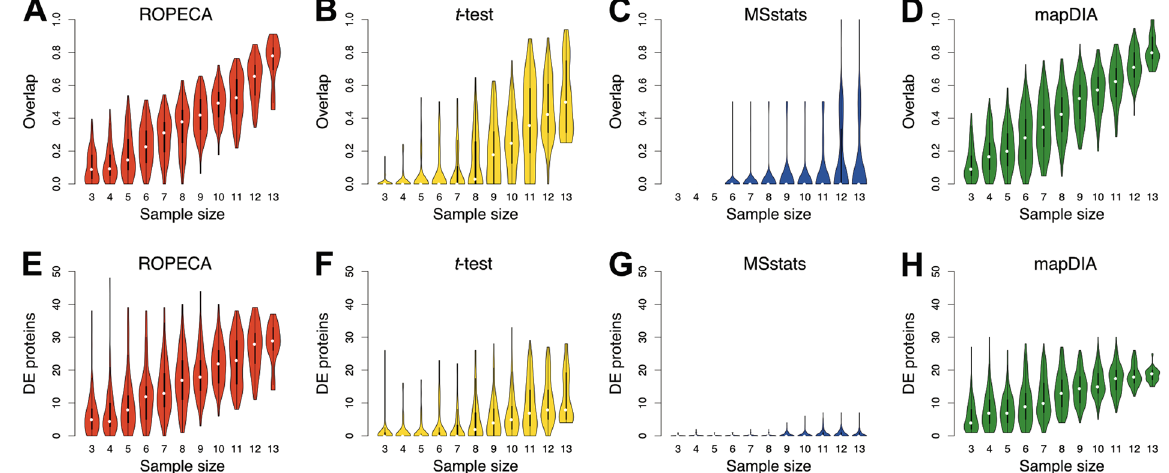
Figure 3. Reproducibility of the results in the clinical twin study. ( A–D) Violin plots showing the proportion of overlapping differentially expressed proteins (FDR < 0.05) between the full data set (i.e. using all available samples) and 100 random subsets of 3–13 individuals diagnosed with type 2 diabetes (T2D) using ROPECA, t -test, MSstats, and mapDIA. Differential expression analysis was performed between subjects diagnosed with T2D and the rest of the study population (n = 102). ( E–H) Violin plots showing the total number of differentially expressed proteins in the subsets analysed in Figure ( A–D